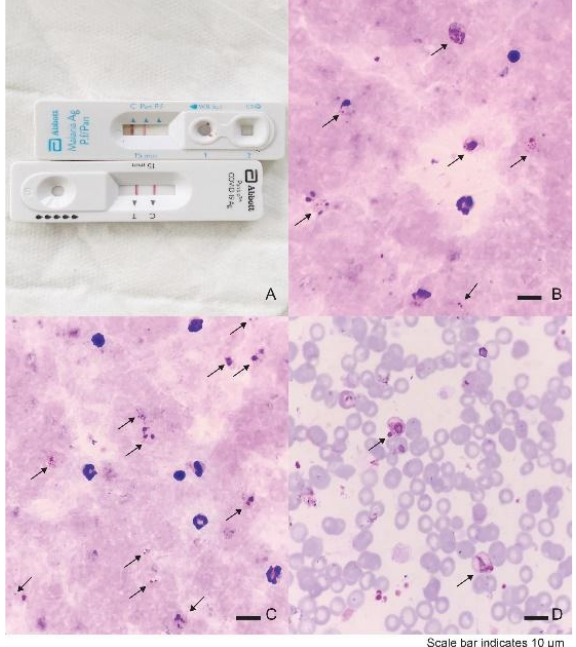
Figure 1. Malaria and COVID-19 diagnostic test results. ( A ) A malaria rapid diagnostic test (upper) was Pan- Plasmodium -positive and a SARS-CoV-2 antigen test (lower) was positive. ( B , C ) Thick blood film showing several stages of P. vivax (arrows), magnification × 1000, Giemsa’s stain. ( D ) Thin blood film showing infected red blood cell with P. vivax (arrows), magnification × 1000, Giemsa’s